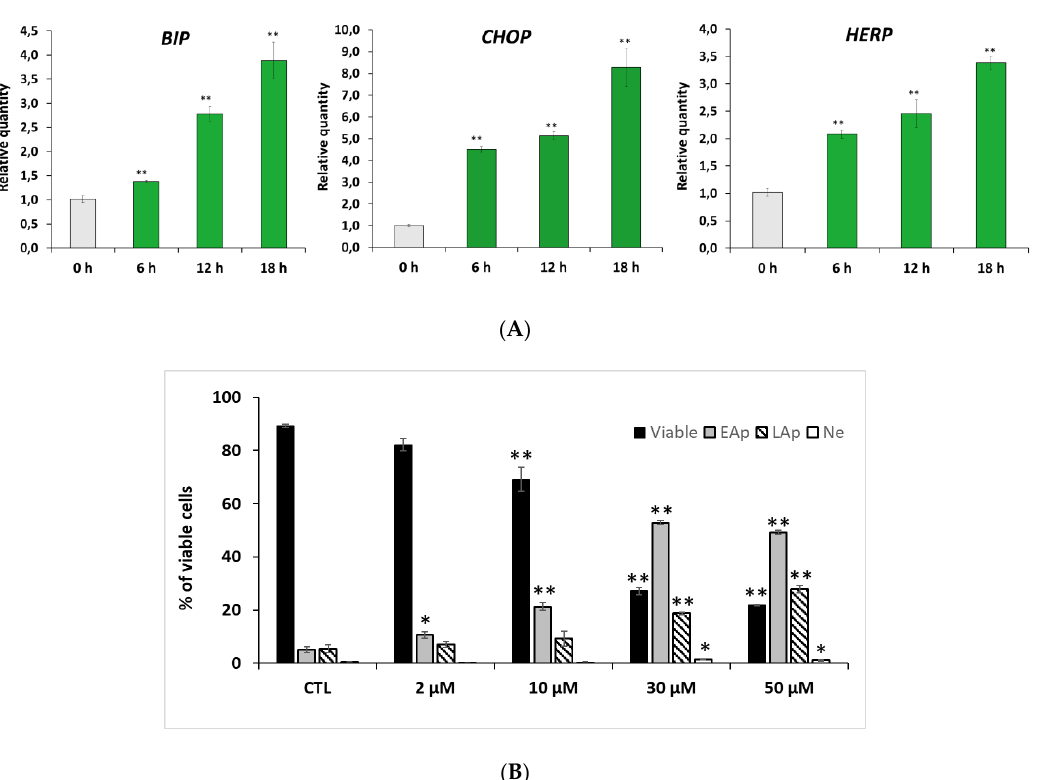
Figure 3. RM-581 triggers ER-stress mediated apoptosis of PC-3 cells. ( A ) mRNA expressions of BIP , CHOP, and HERP in PC-3 cells treated with RM-581 (5 µM) at 6, 12, and 18 h post-treatment. ( B ) Effect of RM-581 on viable, early apoptotic (EAp), late apoptotic (LAp), and necrotic (Ne) PC-3 cells. After cells (3 × 10 5 ) had been exposed to RM-581 for 72 h at different concentrations, the number of each cell type was measured by flow cytometric analysis using propidium iodide dye. Each data point represents the mean of an experiment performed in triplicate (mean ± SD). * p < 0.05, ** p < 0.01 vs. 0 h or control (CTL).